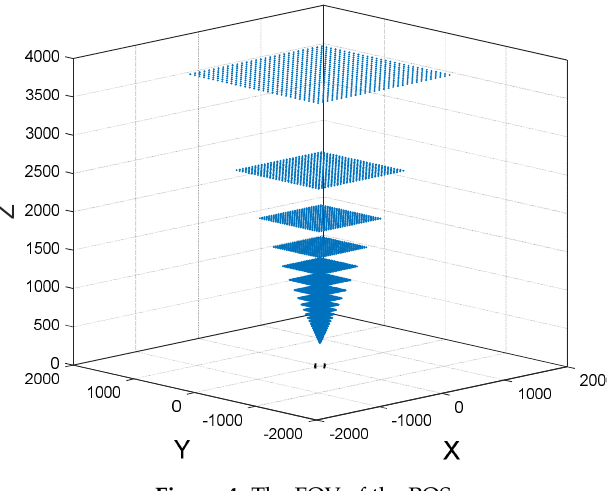
Figure 4. The FOV of the POS.